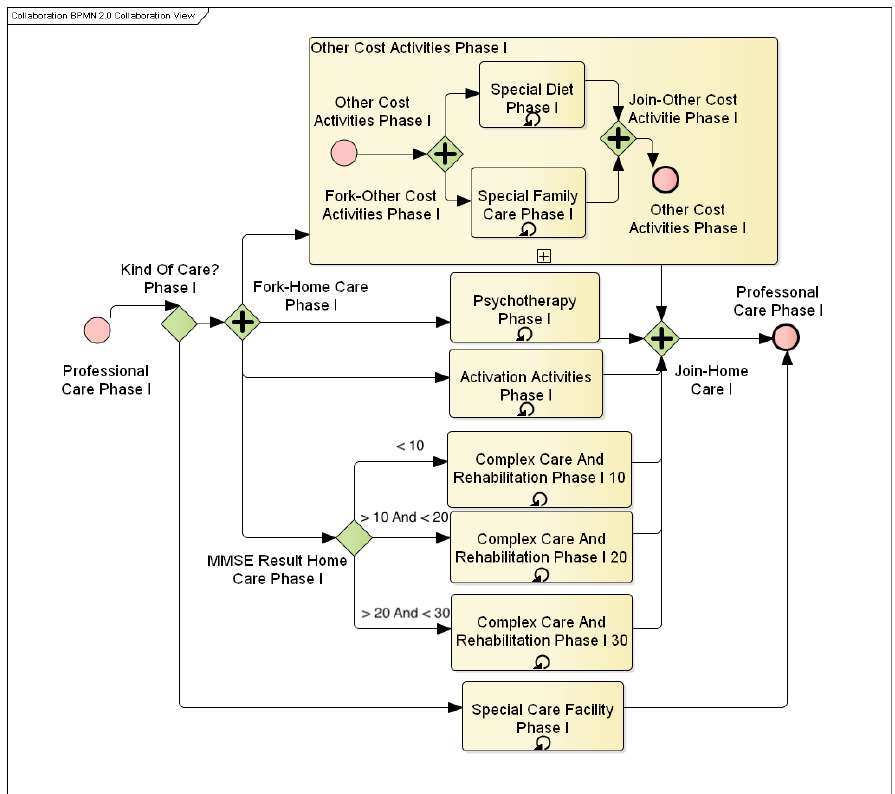
Figure 7. BPMN subprocess of Alzheimer’s disease in Phase